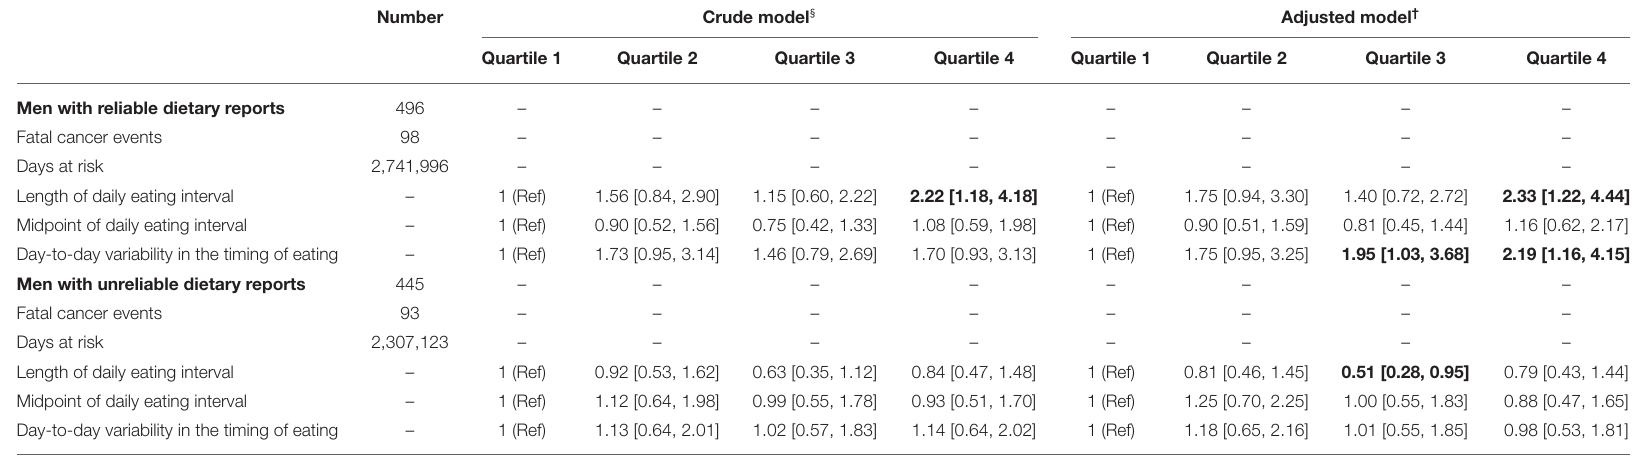
TABLE 2 | Association of meal timing variables with cancer mortality among men with and without reliable dietary